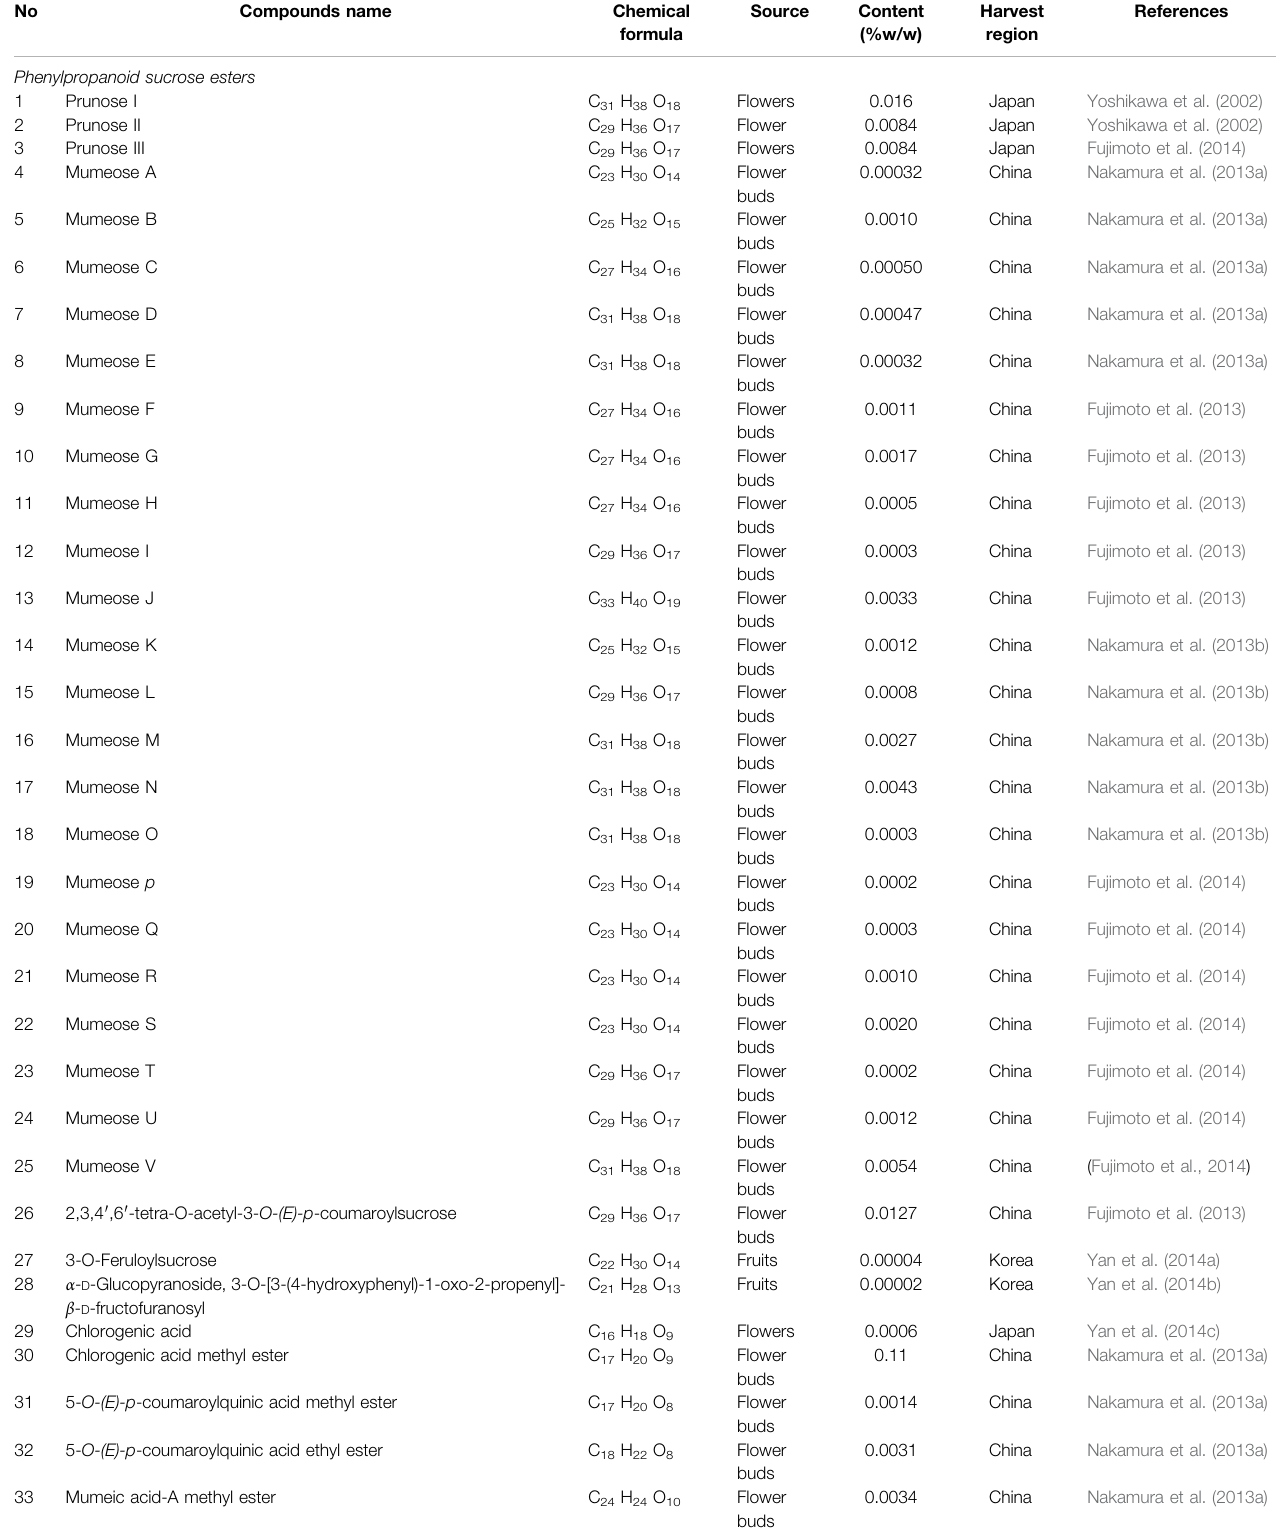
TABLE 1 | List of 192 compounds isolated from P. mume